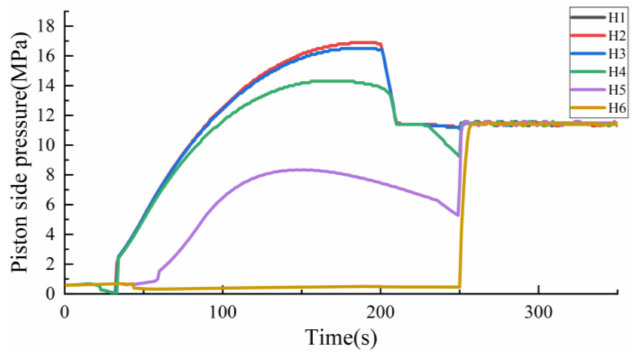
Figure 16. Piston side pressure of different leakage clearance.